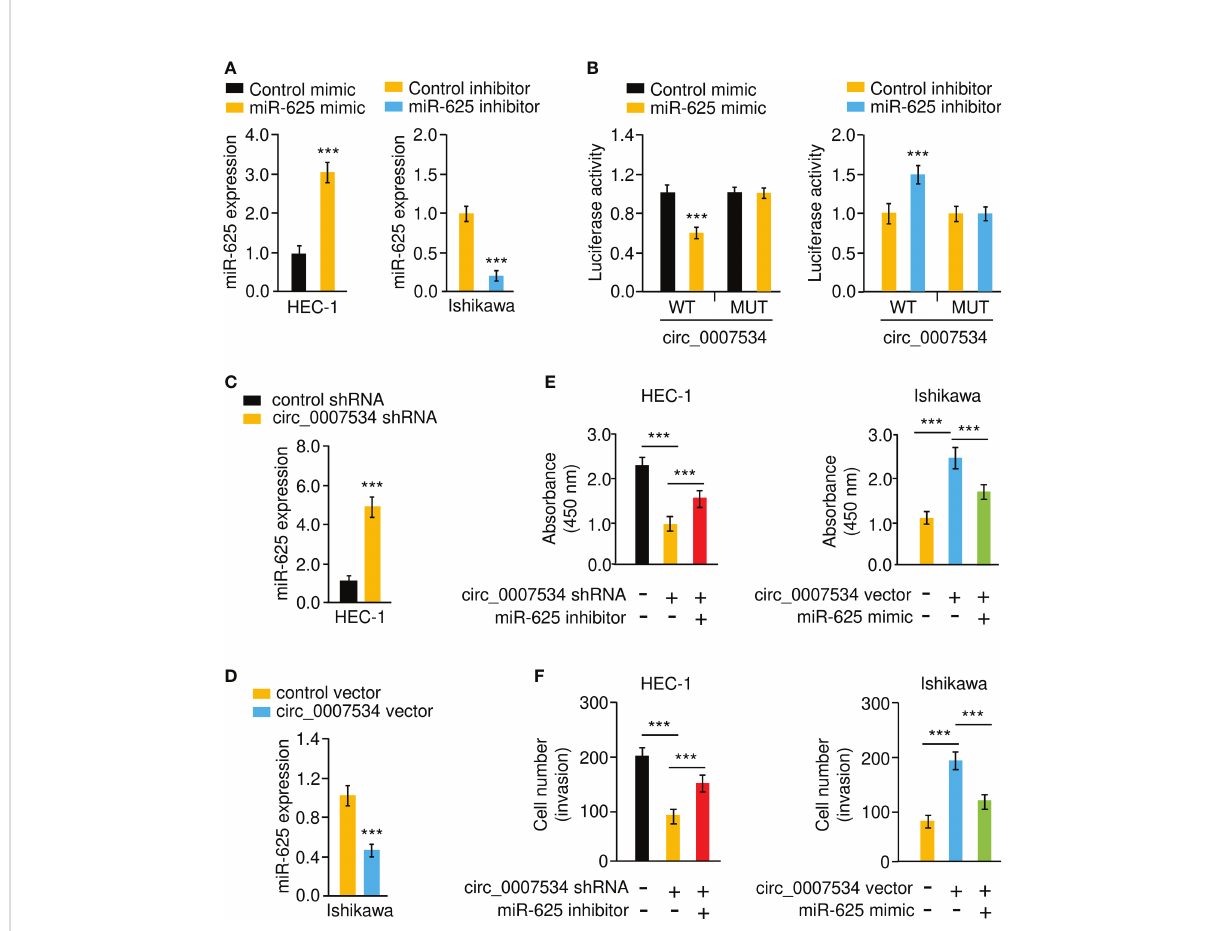
FIGURE 6 Circ_0007534 sponges miR-625 to promote endometrial cancer cell proliferation and invasion. (A) MiR-625 expression in endometrial cancer cells transfected with miR-625 mimic or inhibitor. (B) Luciferase reporter assay of endometrial cancer cells transfected with miR-625 mimic, miR-625 inhibitor, and luciferase reporter plasmids containing WT or MUT circ_0007534. (C, D) The expression of miR-625 in HEC-1 cells after knockdown of circ_0007534 (C) , or in Ishikawa cells after overexpression of circ_0007534 (D) was examined. (E) The proliferation of HEC-1 cells transfected with circ_0007534 shRNA, miR-625 inhibitor, or the respective controls (left). The proliferation of Ishikawa cells transfected with circ_0007534 vector, miR-625 mimic, or the respective controls (right). (F) The invasion of HEC-1 cells transfected with circ_0007534 shRNA, miR-625 inhibitor, or the respective controls (left). The invasion of Ishikawa cells transfected with circ_0007534 vector, miR-625 mimic, or the respective controls (right). *** P <